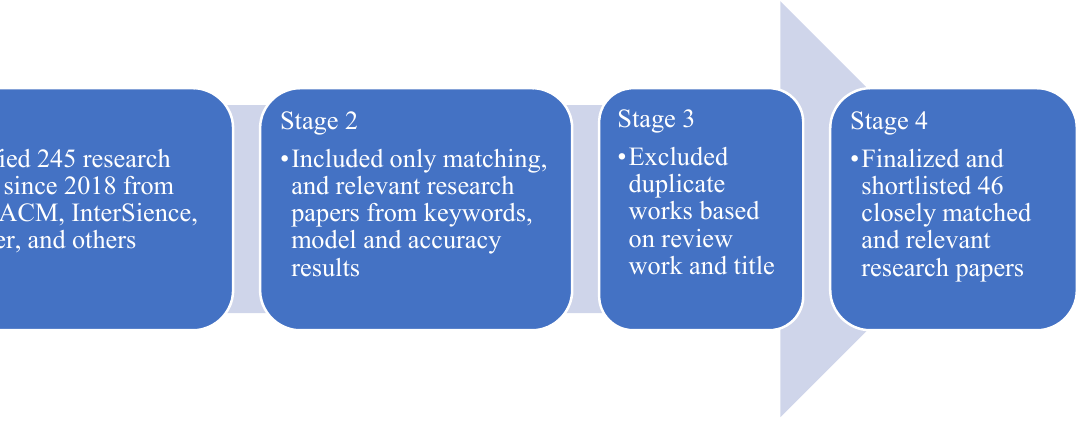
Figure 1. Research papers selection process.